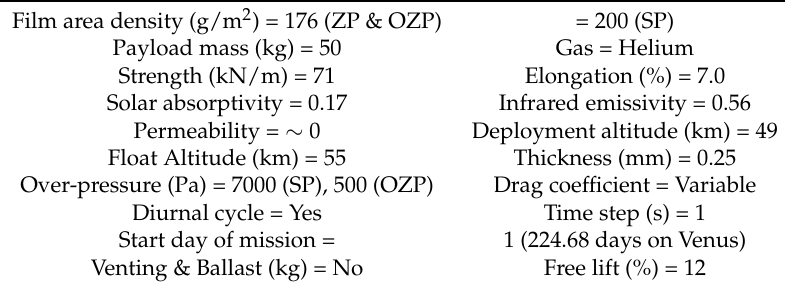
Table 4. Venus aerobot parameters. Parameters are based on [43,47,50].